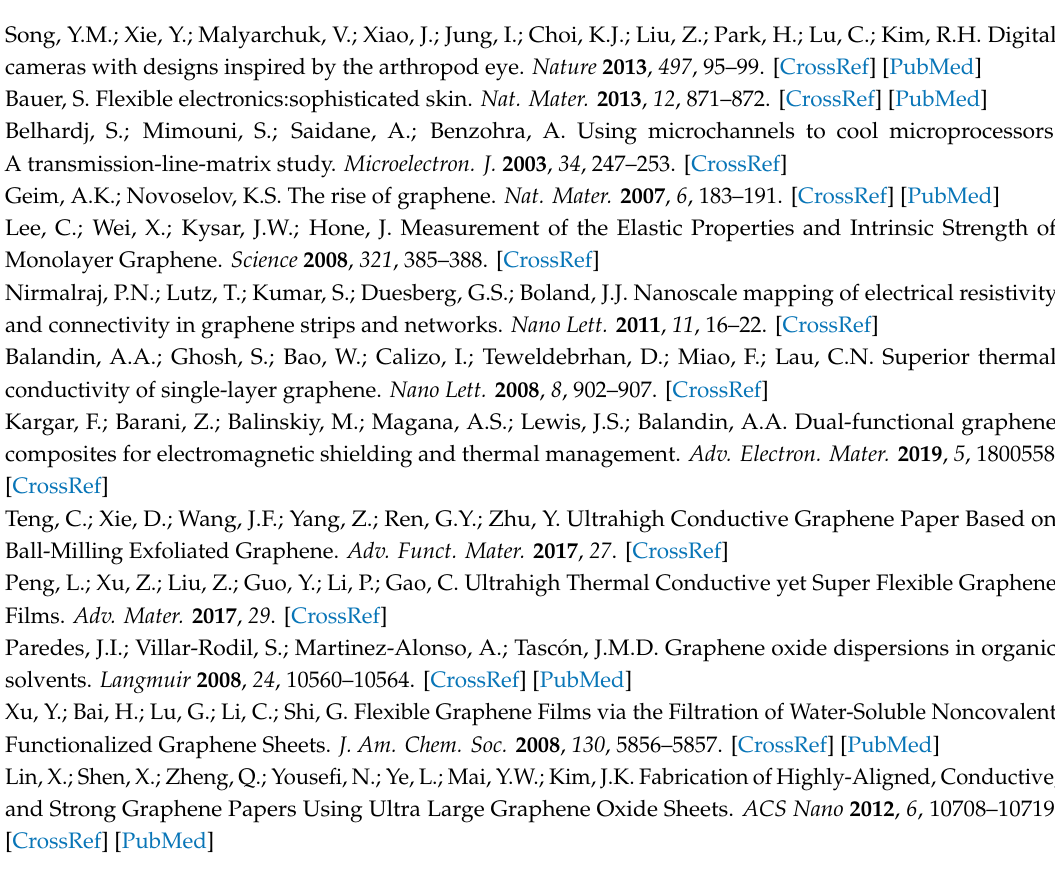
Figure S1: The dispersion solution of GO, obtained after secondary oxidation reaction; Figure S2: The route of reaction for the partial reduction of GO by oxygen negative Vitamin C ions; Figure S3: Procedure temperature reduction rGO / VC films; Figure S4: GO / VC films with a size of 22 × 30 cm; Figure S5: Heat transfer simulation results of rGO / VC-15% films with COMSOL multiphysical (Multiphysics 5.3a, COMSOL, Stockholm, Sweden) field simulation software; Figure S6:The change of terminal temperature of rGO / VC-15% film during heat transfer simulation test; Table S1: The thickness and the bulk density of samples in the LFA 447 Nanoflash measurement. Author Contributions: Conceptualization, J.L. (Jing Li) and J.L. (Jinfeng Lai); Data curation, J.L. (Jing Li) and